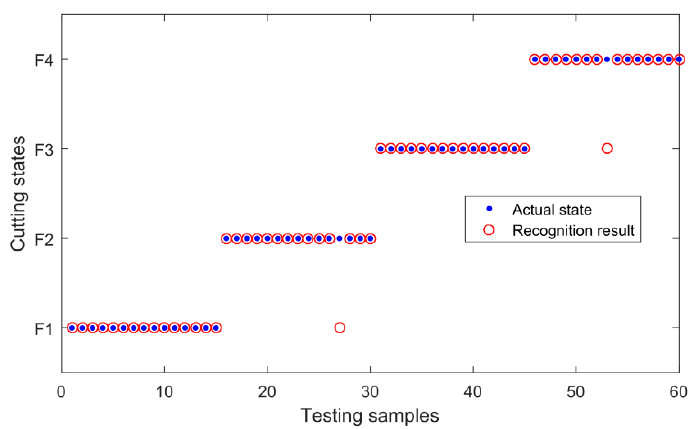
Figure 19. Recognition results based on the proposed method.